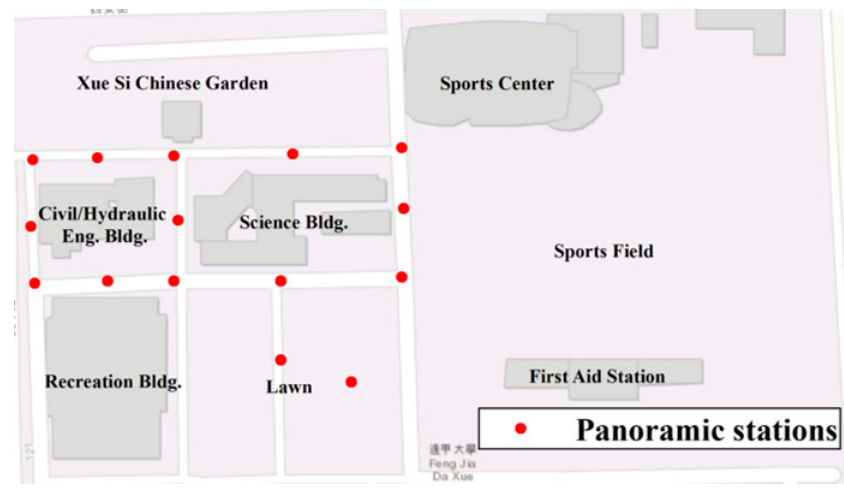
Figure 5. Panoramic stations (red points) for capturing images.